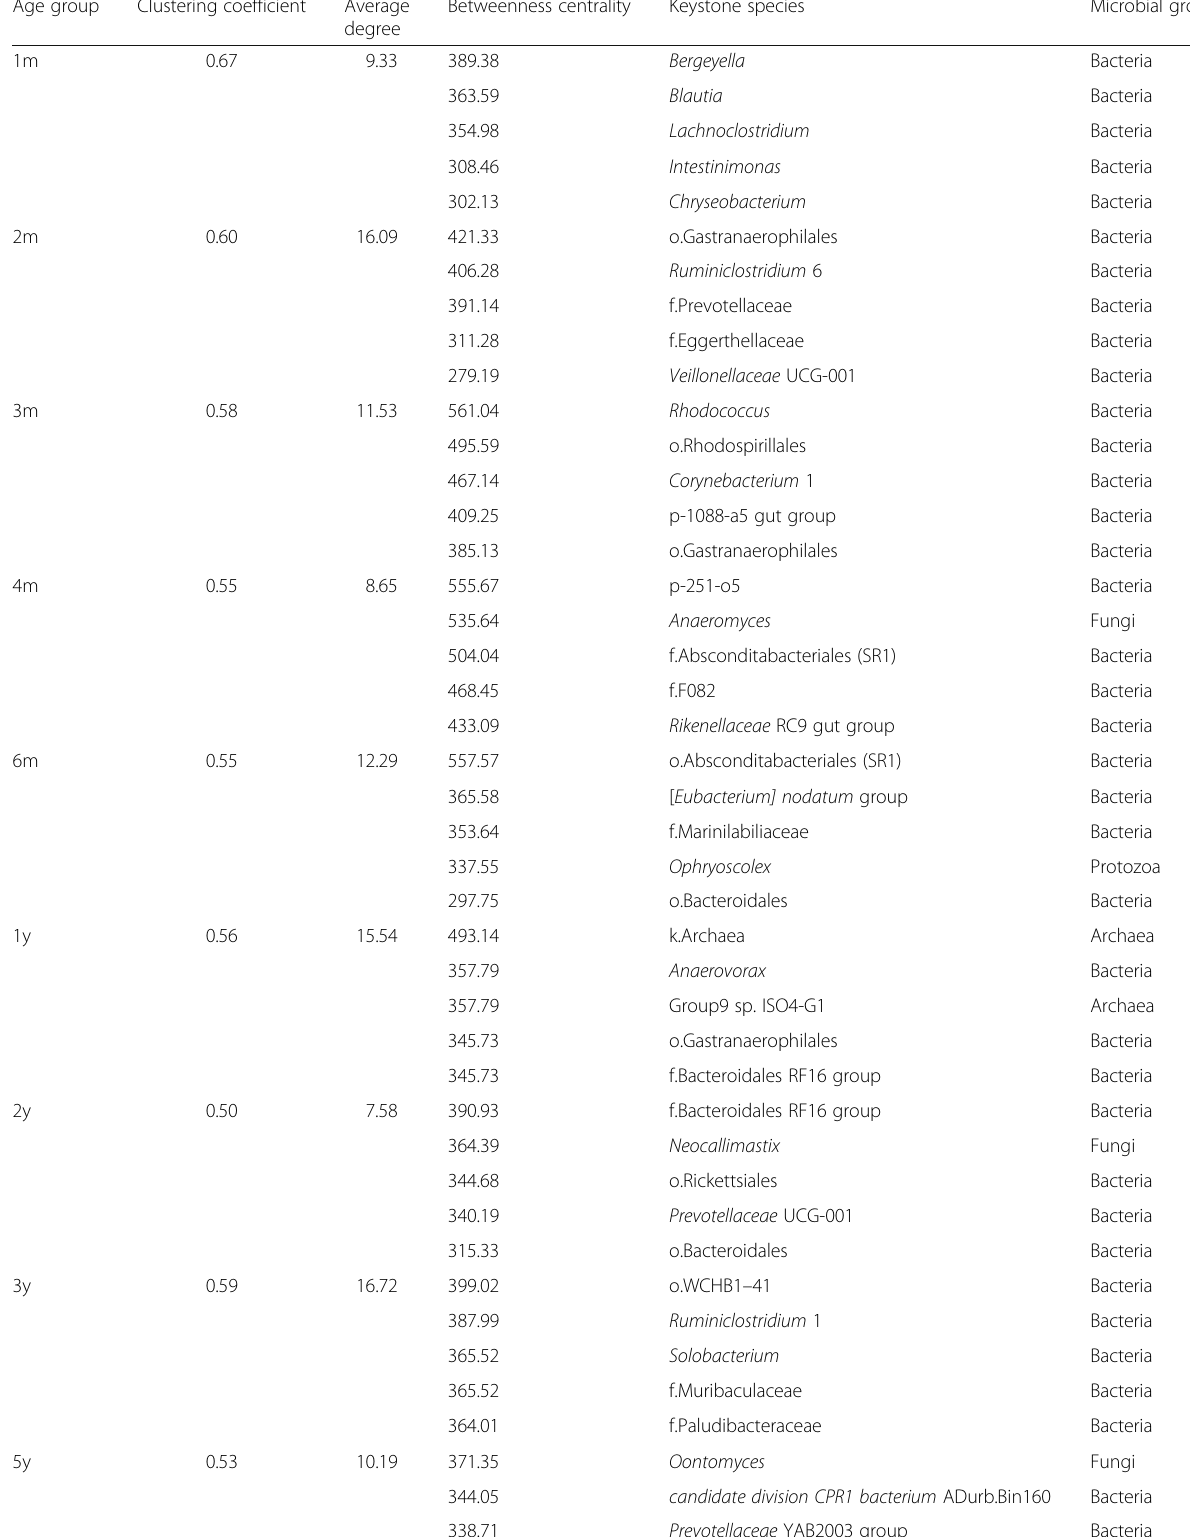
Table 3 Topological properties and keystone species of co-occurring networks of inter-kingdom interactions Age